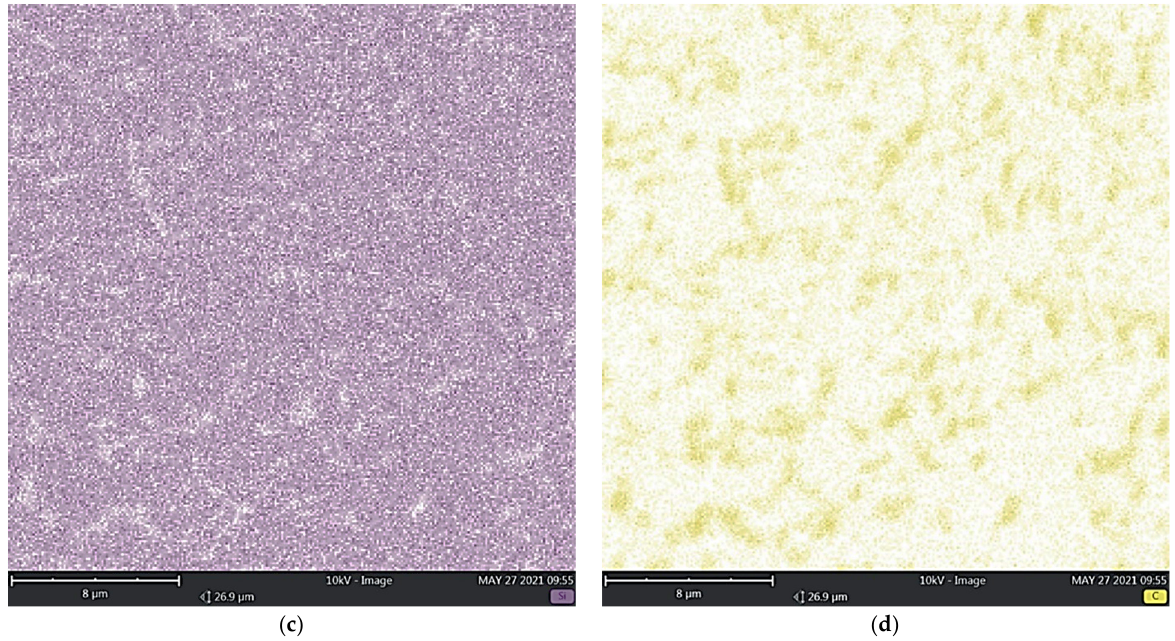
Figure 7. The microstructure of the transition zone 1 and the distribution map EDS of elements in this area: ( a ) tested area, SEM, mag. 10,000×, nonetched sample; ( b ) distribution of Fe at concentrations in the tested area 50.81 %at./77.01 %wt.; ( c ) distribution of Si at concentrations in the tested area 15.93 %at./12.15 %wt.; ( d ) distribution of C at concentrations in the tested area 33.25 %at./10.84 %wt.